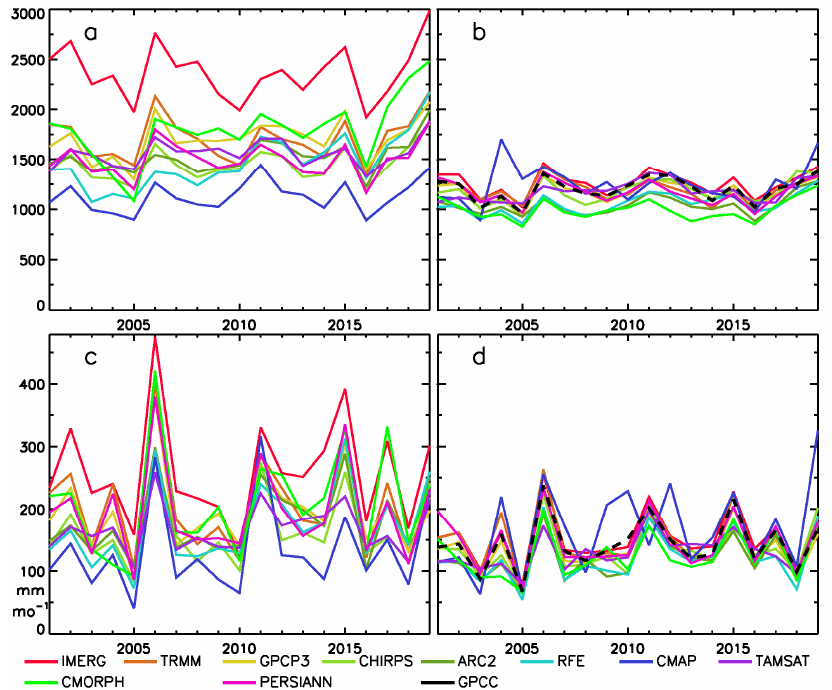
Figure 14. Interannual variability of rainfall (mm/yr or mm/mo) based on satellite products: ( a ) Lake Victoria, annual ( b ) catchment, annual ( c ) Lake Victoria, November ( d ) catchment, November.